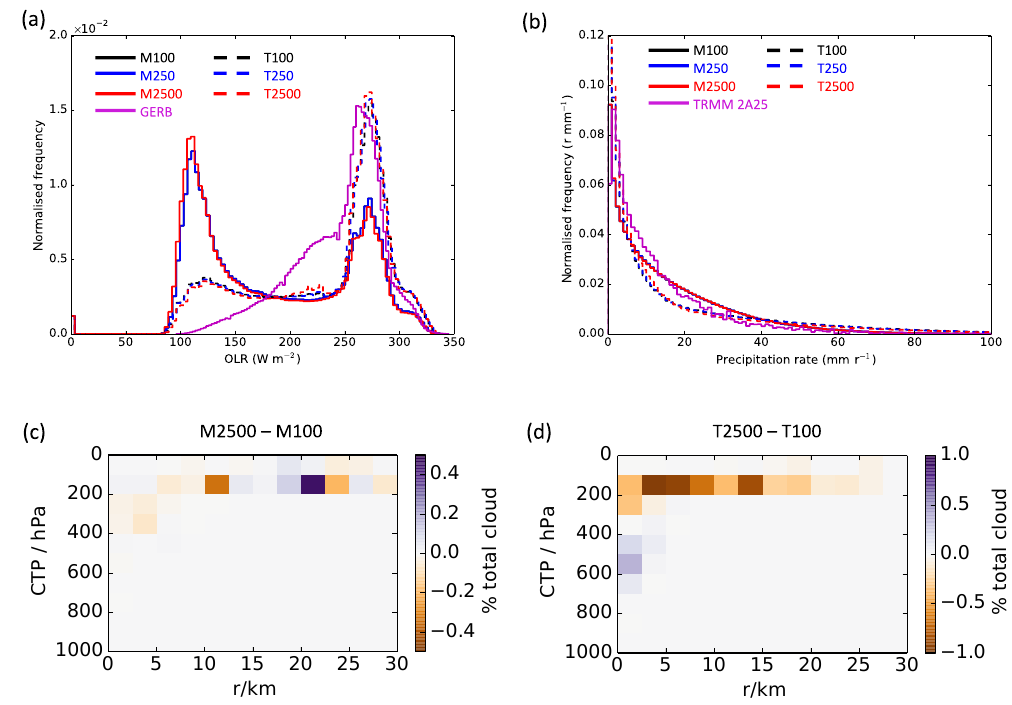
Figure 2. Congo case: (a) frequency distributions of OLR from the WRF simulations and observations from GERB over the period 1 to 10 August 2007; (b) self-weighted precipitation rate distributions from the WRF simulations and observations from the ungridded TRMM 2A25 product, which has a similar spatial resolution to the 4km model grid length; (c) difference in the joint distribution of cloud top pressure in updraughts (identified by masking points where the maximum vertical velocity exceeds 1ms − 1 and then applying a connected-components labelling algorithm to identify unique updraught areas) and horizontal radius of updraughts when CDNC is increased from 100 to 1000cm − 3 using the Morrison microphysics scheme; (d) difference in the joint distribution of cloud top pressure in updraughts and horizontal radius of updraughts when CDNC is increased from 100 to 1000cm − 3 using the Thompson microphysics scheme.